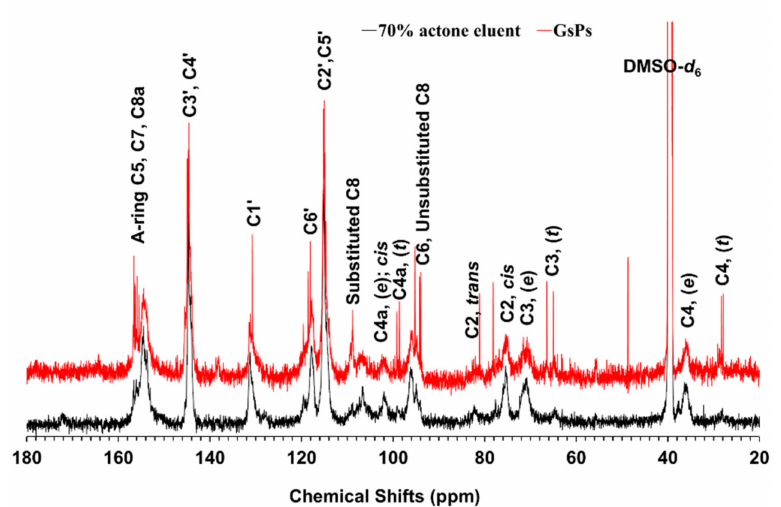
Figure 3. The 13 C NMR spectrum the 70% acetone eluent of the rhizome of F. dibotrys and